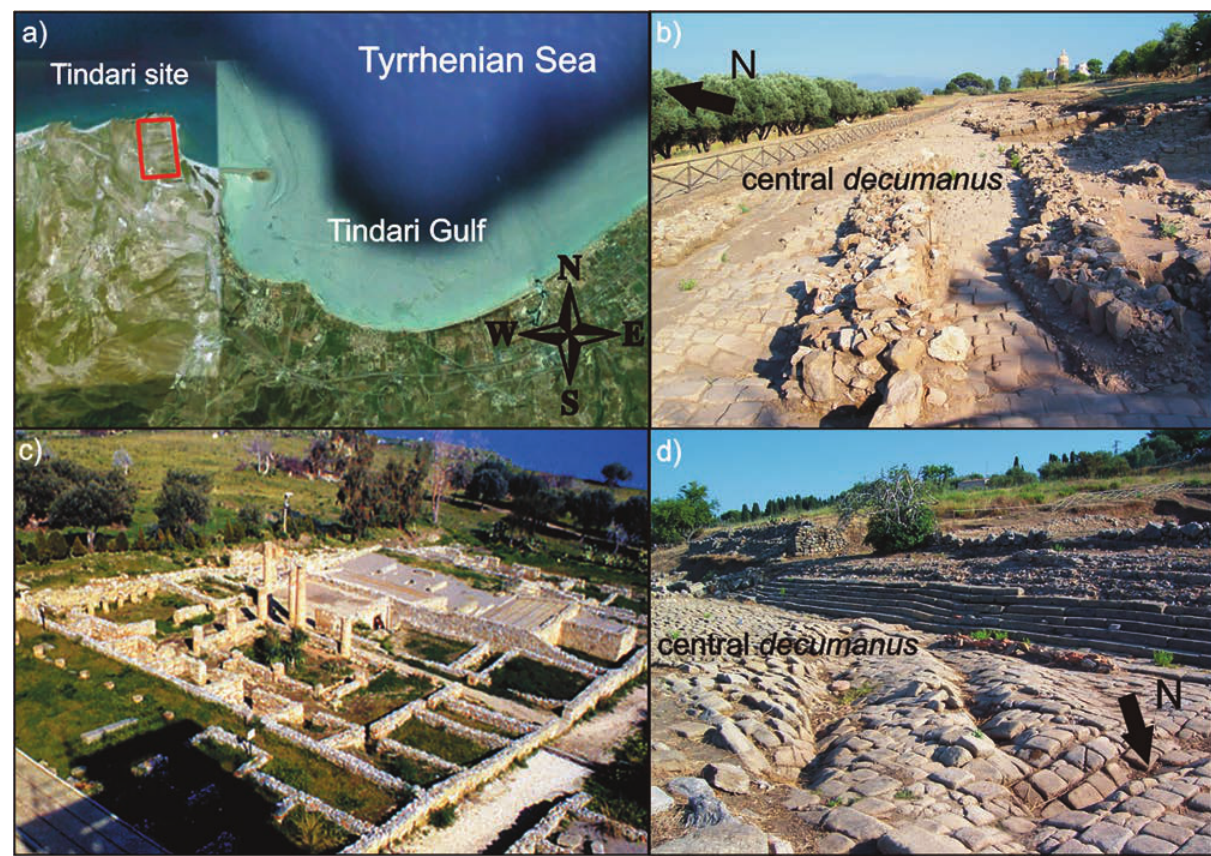
Figure 9. a) Google Earth image of the Tindari Gulf; b) the old Greco-Roman site of Tindari c) the central decumanus; d) strong undu- lating deformations in the road-bed of the central decumanus [Spigo 2005] associated to the 4th century